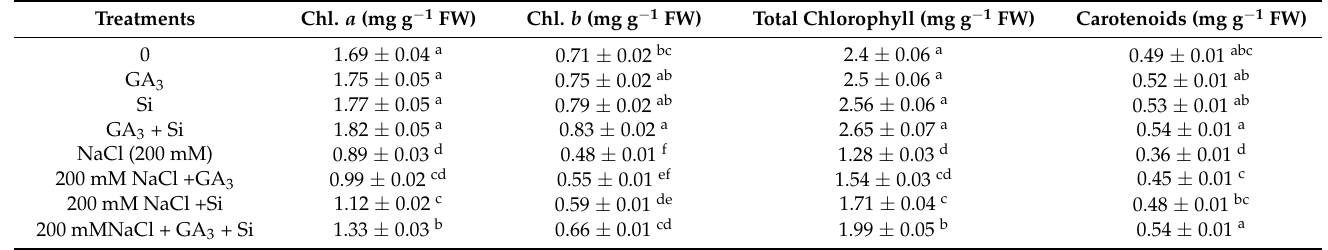
Table 2. Impact of gibberellic acid (GA 3 ) and silicon (Si) application on pigments of B. juncea cultivated under NaCl